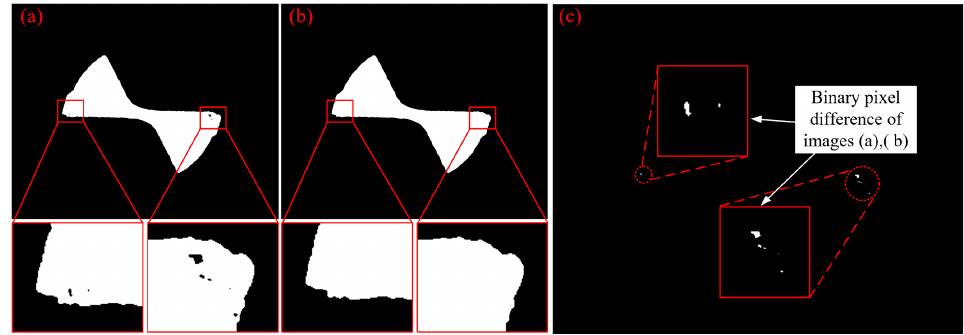
Figure 12. Morphological hole filling result: ( a ) segmented image by region growing method; ( b ) image after morphological hole filling; ( c ) comparison image before and after filling holes.